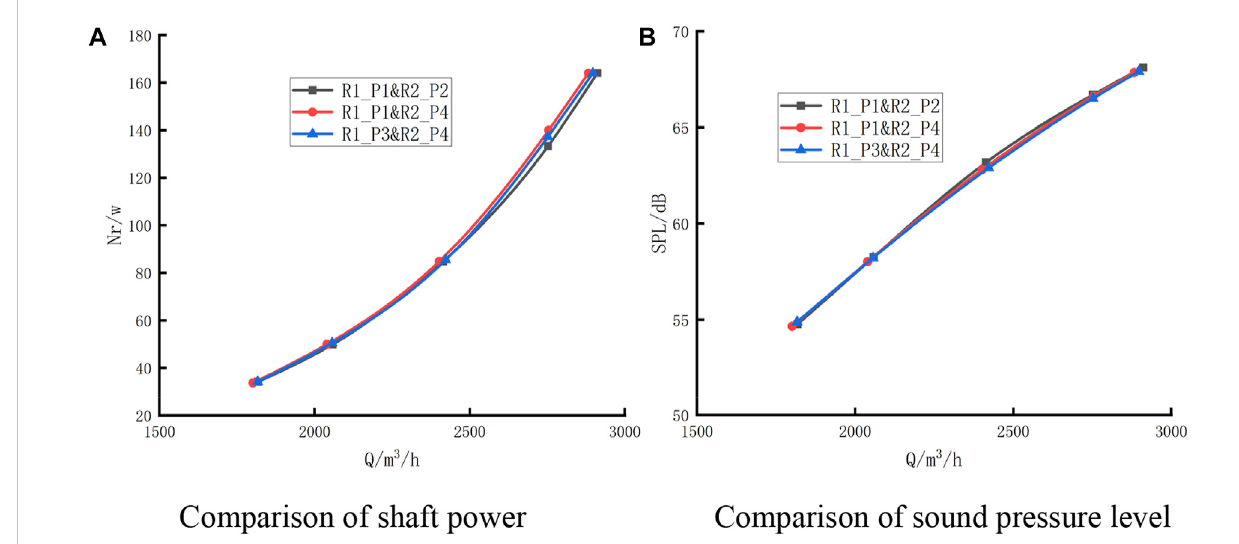
FIGURE 9 Variable rotational speed regulation characteristics of the fan with different axial distances: (A) comparison of shaft power; (B) comparison of SPL.